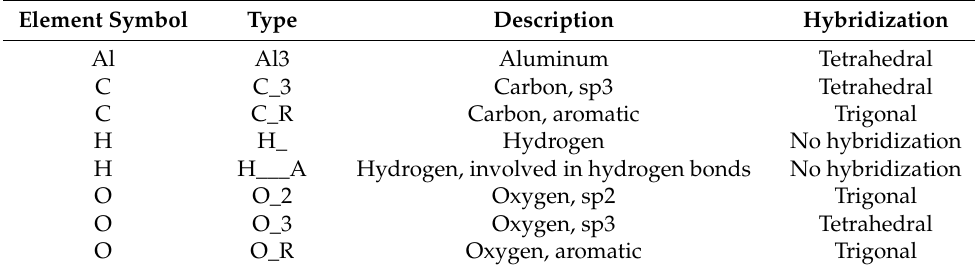
Table A1. Force field type used in molecular dynamics simulation of aluminum sol. Element